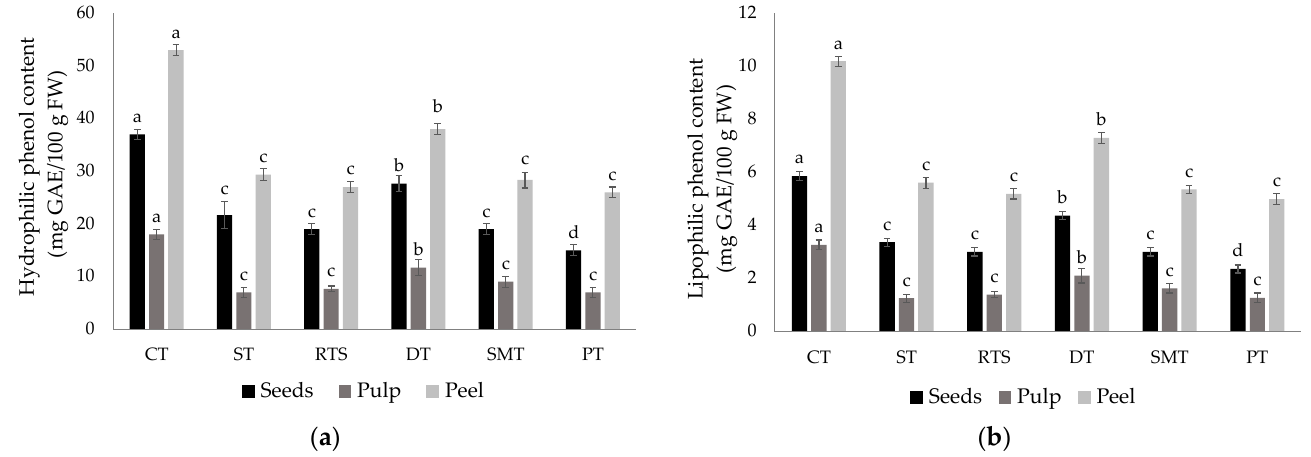
Figure 2. Hydrophilic ( a ) and lipophilic phenol content ( b ) in the seeds, pulp, and peel fractions of each tomato cultivar: Cherry tomato (CT), Smooth round tomato (ST), Round tomato sauce (RTS), Datterino tomato (DT), S. Marzano tomato (SMT), and Piccadilly tomato (PT). The histograms represent mean ± SD. Results were analysed by one-way analysis of variance (ANOVA) followed by Holm-Sidak’s multiple comparisons test. Different letters indicate significant differences within each fraction among di ff erent tomato cultivars ( p < 0.001).